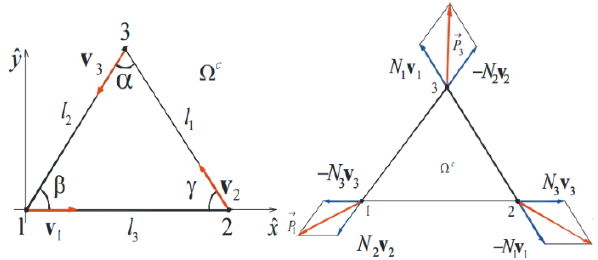
Figure 3: Natural Membrane Finite Element (a) unit vectors, (b) internal forces